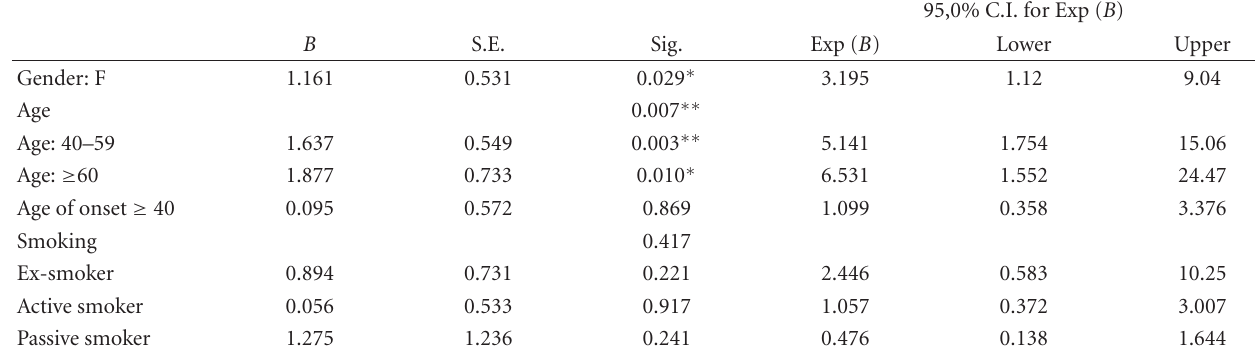
Table 4: Multiple regression